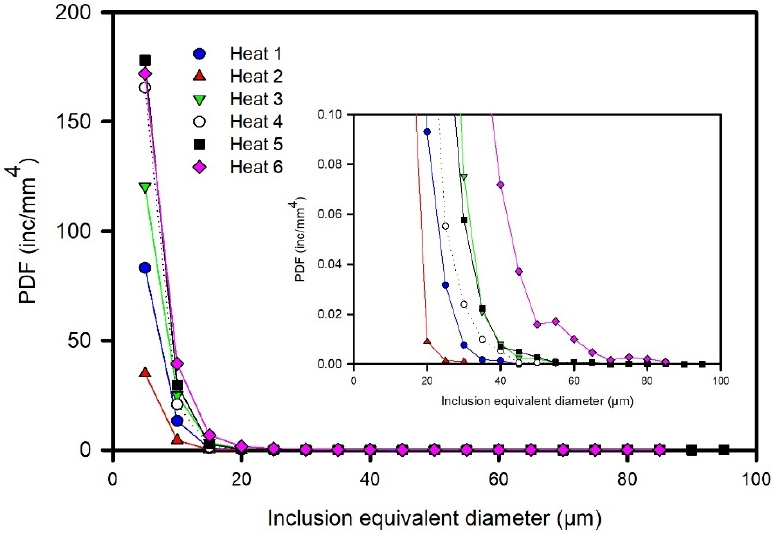
Figure 3. Evolution of the population density function PDF.